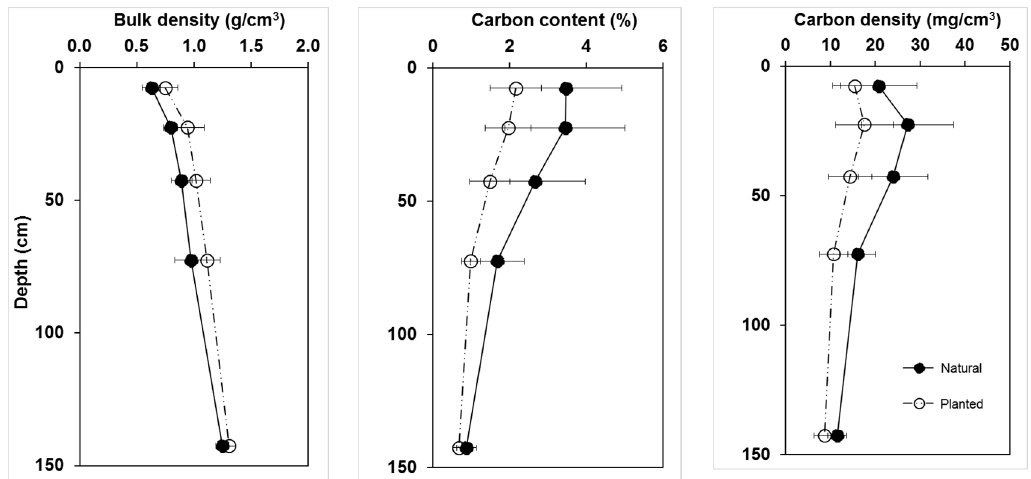
Figure 2. Soil properties according to forest type in northern Vietnam.